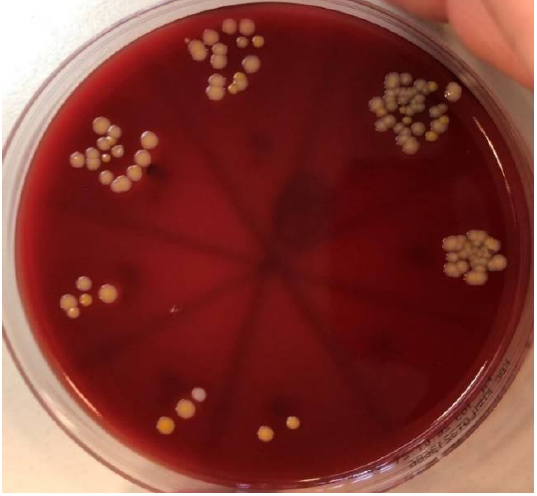
Figure 9. Colonies of Staphylococcus aureus and Candida albicans on 5% blood agar.